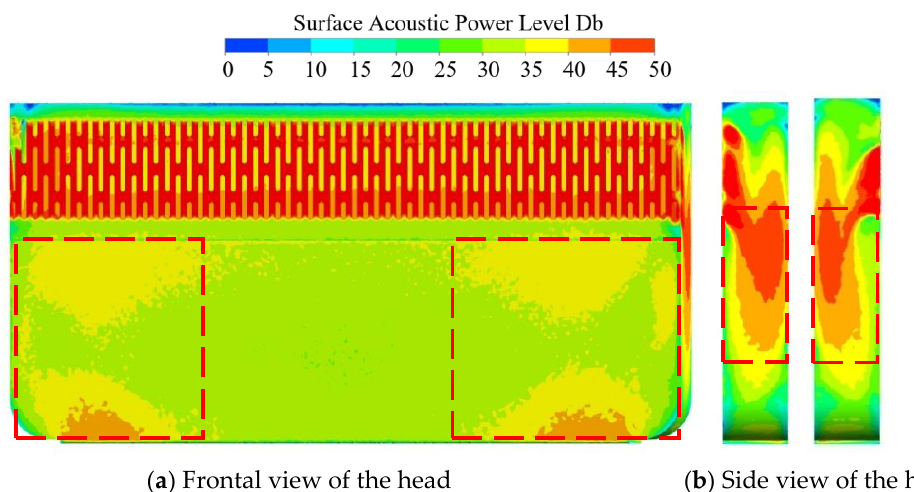
Figure 9. Integrated stove prototype head surface broadband noise distribution.